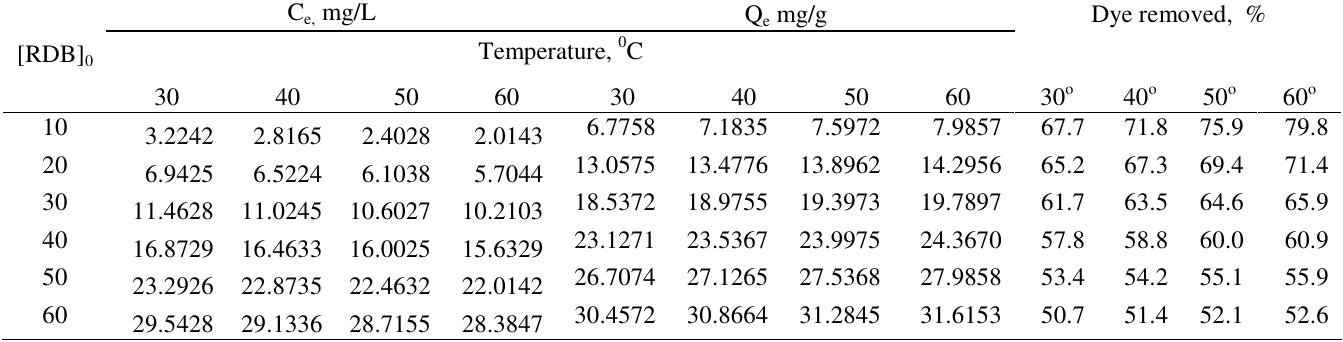
Table 2 . Equilibrium parameters for the adsorption of Dye onto activated Carbon